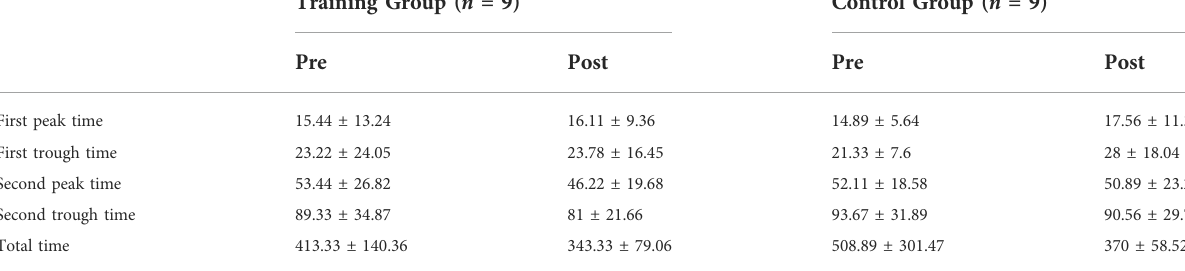
TABLE 4 Landing time parameters